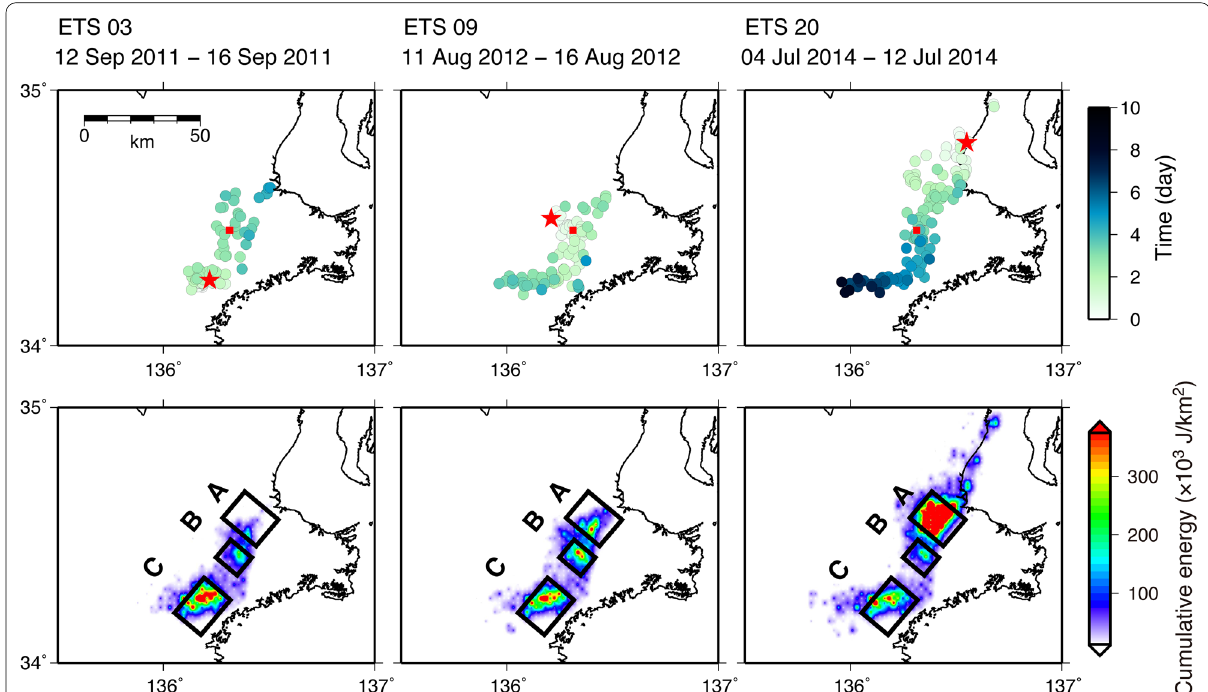
Fig. 5 Examples of three ETS events with contrasting histories. (upper) The migration of tremor hypocenter clusters from their starting point (red star). The red square is the seismic array location. (lower) The spatial distribution of cumulative seismic energy release. Black rectangles indicate the location of high-energy